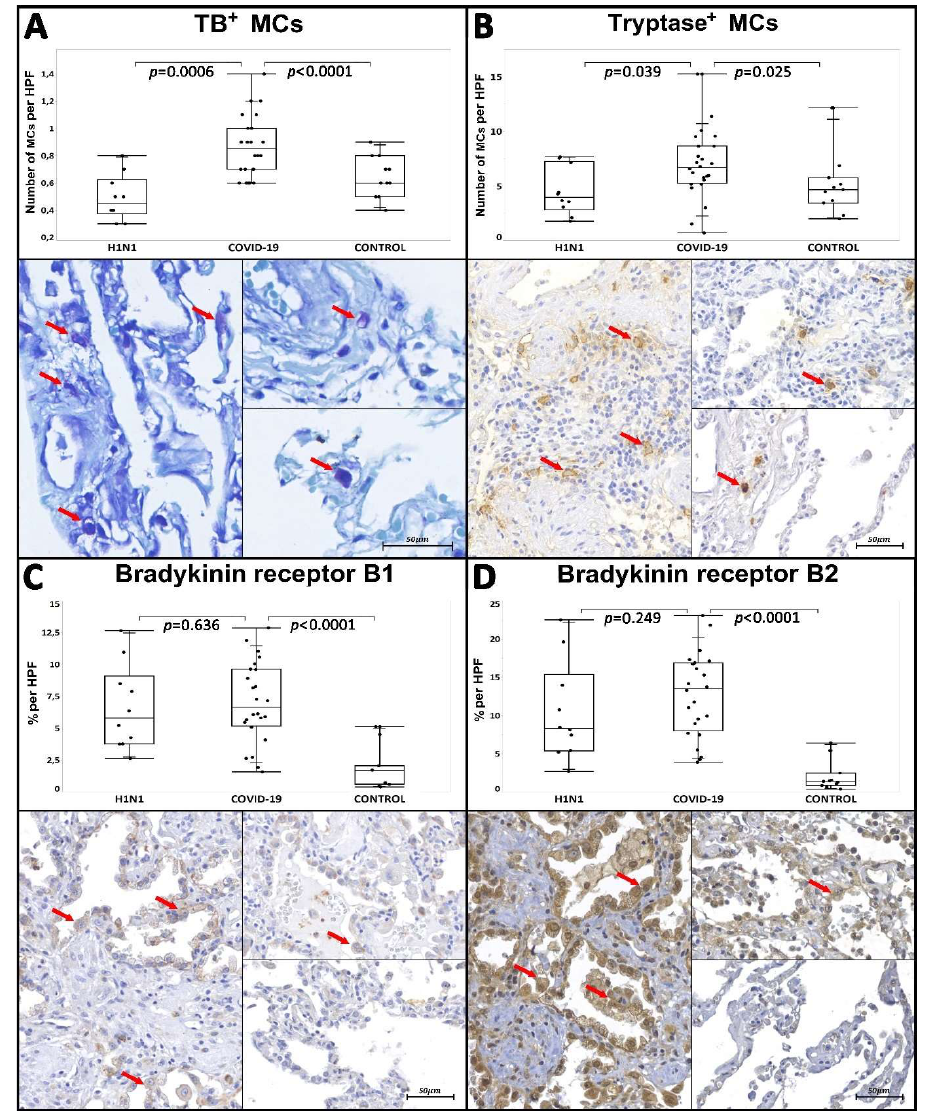
Figure 2. Graphics show Comparison between COVID-19 (left images), H1N1 (right upper images) and CONTROL (right lower images), regarding the density of Toluidine Blue (TB) metachromatic MCs, Tryptase + MCs per HPF (high power field) and tissue Bradykinin receptor B1 and Bradykinin receptor B2 in the percentage of immunoexpression per HPF. ( A ) Metachromatic MCs stained with TB are shown (red arrows) at higher density in the COVID-19 group when compared to the H1N1 and CONTROL groups. ( B ) The density of Tryptase + MCs (red arrow) was also increased in the COVID-19 group when compared to the H1N1 and CONTROL groups. ( C , D ) As for tissue immunostaining of Bradykinin receptors, B1R and B2R was higher in the COVID-19 group (highlighted by red arrows) in comparison to the CONTROL group. However, there was no statistically related difference with the H1N1 group. Images were scanned using the Axio Scan Z1 slide scanner (Carl Zeiss, Jena, Germany): ( B – D ) at 40 × magnification and ( A ) at 63 × magnification. Mann–Whitney nonparametric test. Values of p < 0.05 indicated statistical